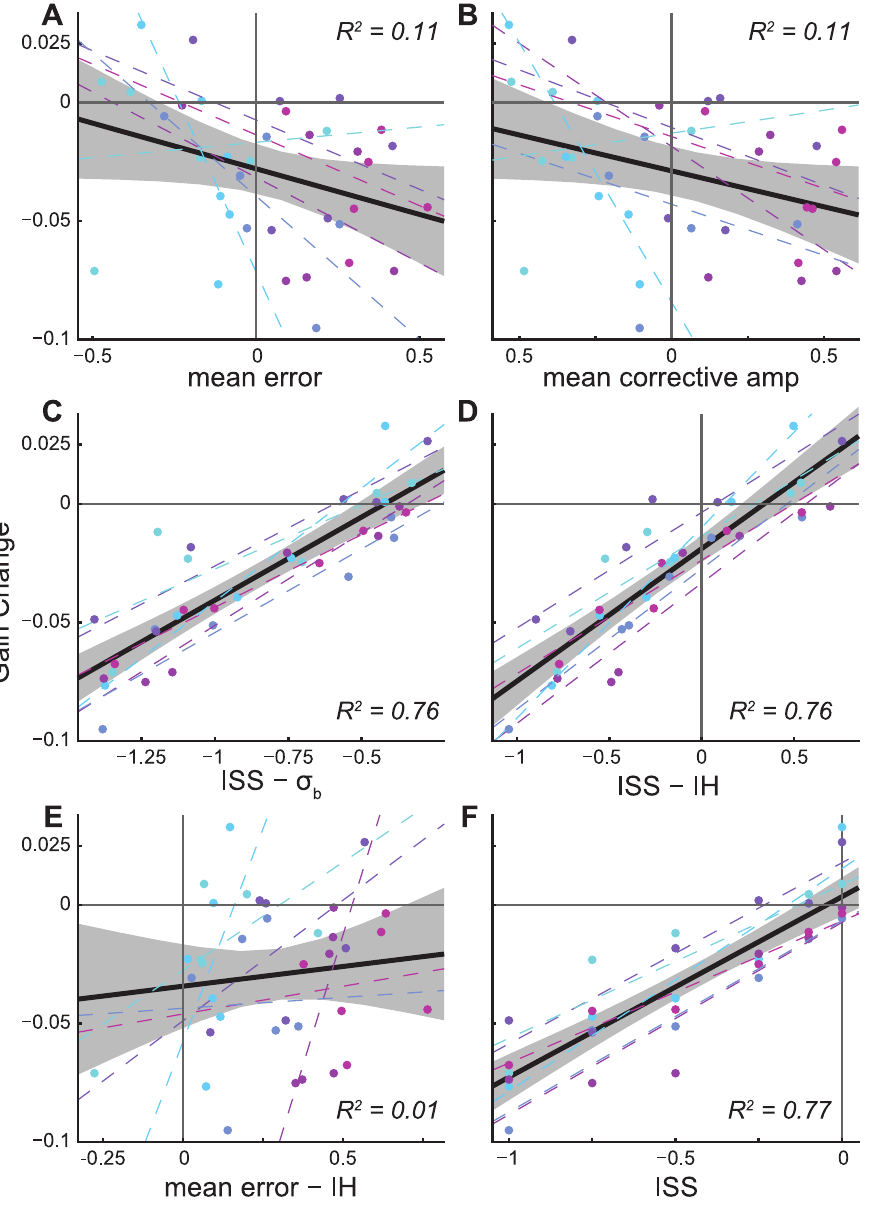
Figure 5. Regression analysis. In all panels, one data point (colored dots) for each subject in each condition (colors as in Figures 2, 4); dashed lines are linear least-squares fits by subject; solid black line and shaded area are linear least-squares fits across subjects and 95% prediction bounds, corresponding R 2 values are inset; solid gray lines are x and y=0, respectively; vertical axis is the mean amount of adaptation (for details of this calculation, see Methods). A. Mean error was calculated using the first 25 trials of adaptation, since error will be most distinct for a given condition in this initial portion of the adaptation phase; see text for clarification. B. Similarly, mean corrective saccade amplitude was calculated only in the first 25 adapt-phase trials. C. The difference between ‘‘inherent hypometria’’ (IH) and baseline end-point variability ( s b ). IH was calculated as the mean undershoot during the final 50 trials of the baseline phase, the same trials were used to calculate baseline s b . D. The difference between ISS and IH. E. The difference between ‘‘mean error’’ and IH. F. Intrasaccadic Step Size in degrees. Note that in this figure, we have chosen to use degrees of visual angle for the abscissa and gain-units for the ordinate.